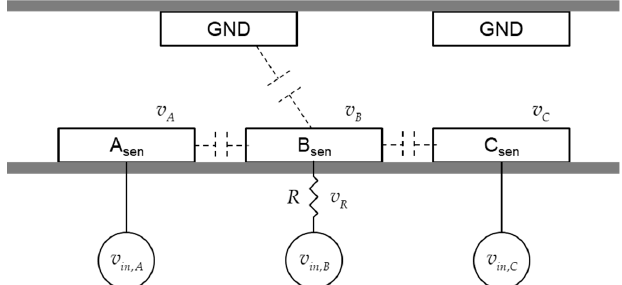
Figure 6. RC circuit construction for capacitance measurement with the voltage of three phases.